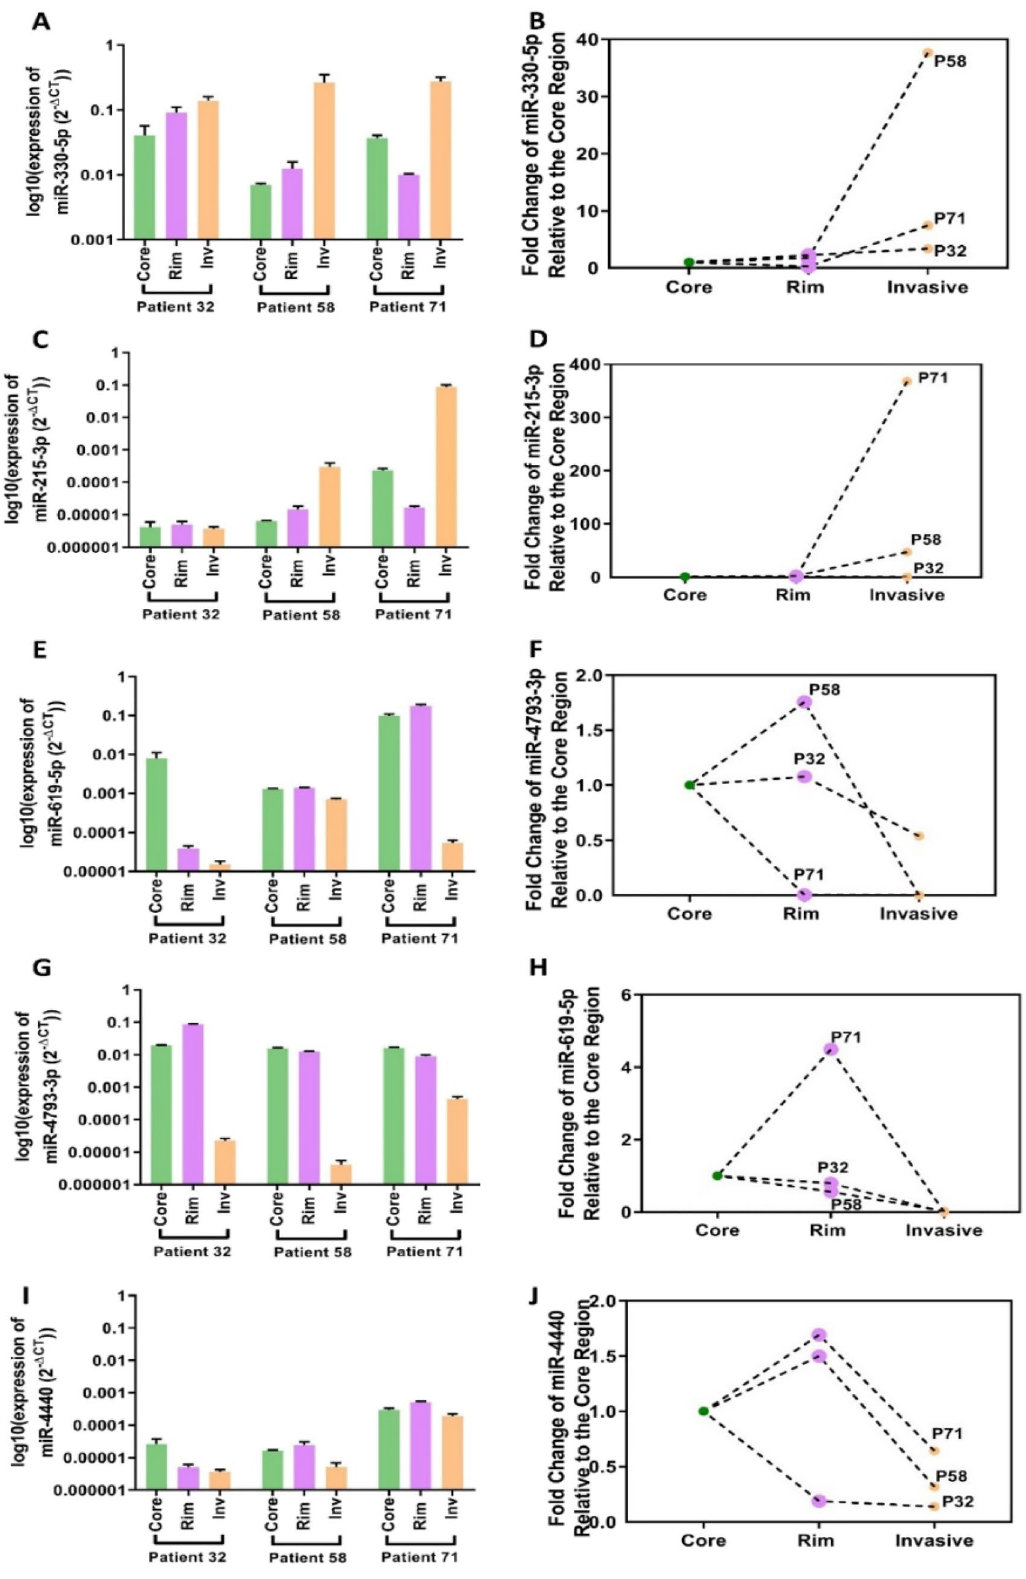
Figure 2. qRT-PCR validation of miRNA expression reported by microarray in an independent GBM patient cohort. Log of expression values for each tumour regions (left panel) and the fold change of the expression value in each tumour region relative to the core region (right panel) are shown for ( A , B ) miR-330-5p, ( C , D ) miR-215-3p, ( E , F ) miR-619-5p, ( G , H ) miR-4794-3p, and ( I , J ) miR-4440. Data is shown for individual GBM patients (n = 3). The numbers 32, 58, and 71 label the different patients. Error bars represent standard error of the mean (S.E.M) of three technical repeats. Statistical significance was not achieved due to the variation in the magnitude of the fold change in miRNA expression between each tumour region in different